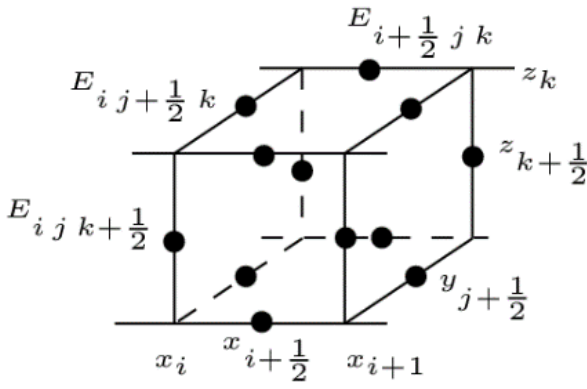
Figure 1. Discrete electric fields attached to the edges of the grid.